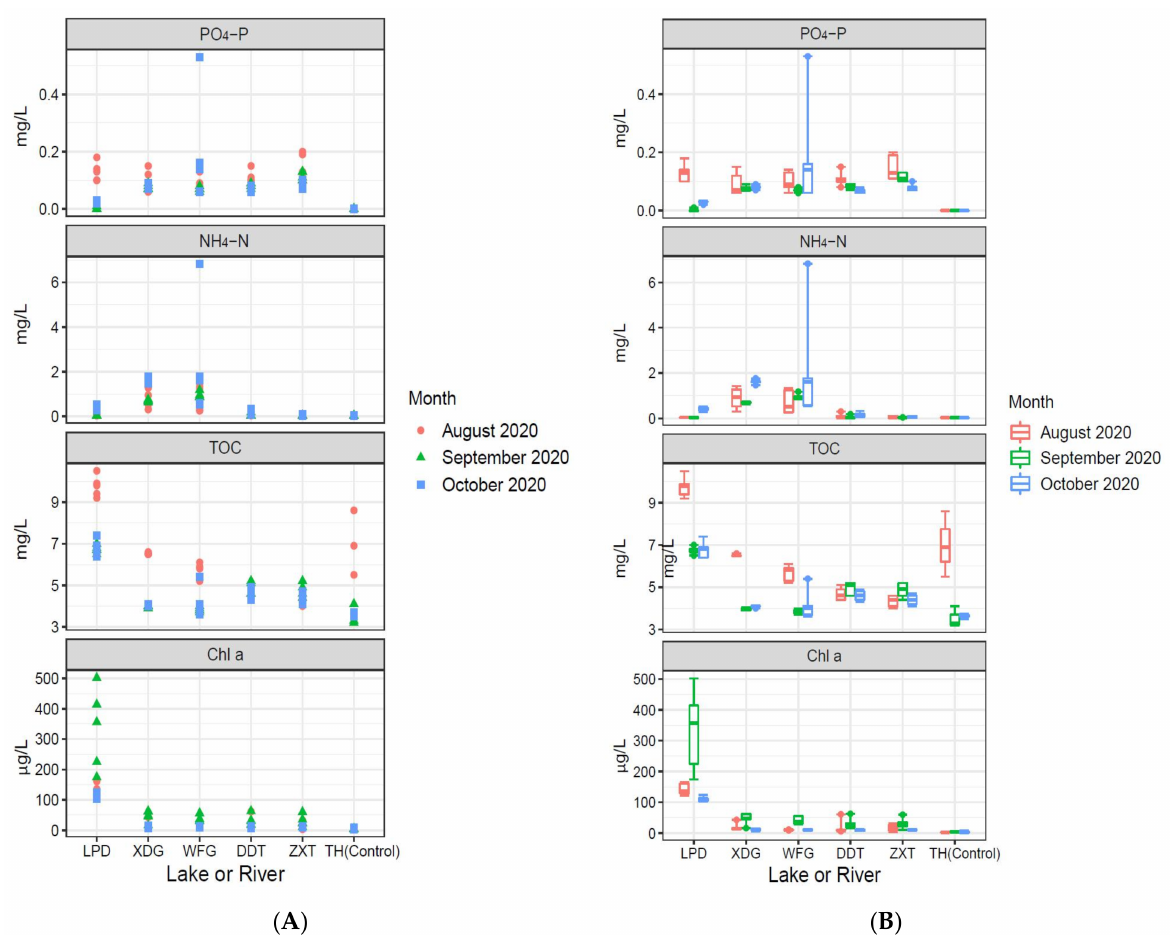
Figure 4. The variation in phosphate (PO 4 -P), ammonia-N (NH 4 -N), total organic carbon (TOC), and Chlorophyll a (Chl a ) values observed in different sampling locations and months. The individual value for each parameter ( A ) and boxplots ( B ) with minimum and maximum values (whiskers), median value (line within each box), and quartile interval (box) are